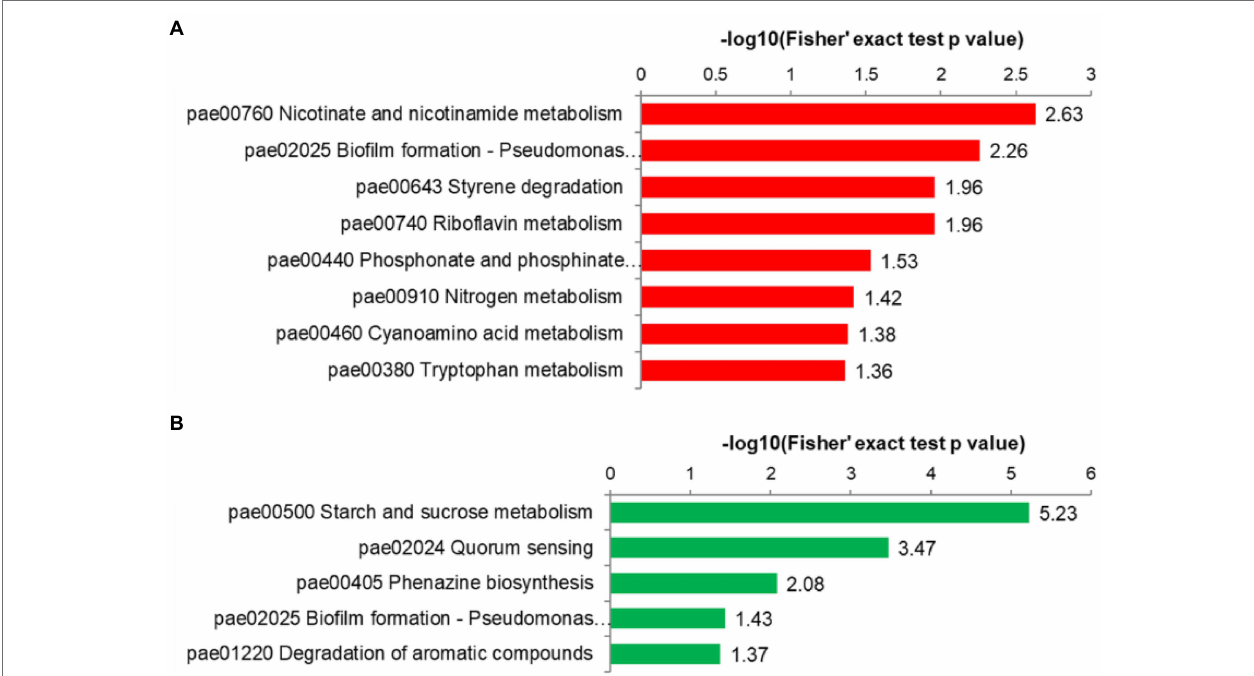
FIGURE 5 | Kyoto Encyclopedia of Genes and Genomes (KEGG) pathway enrichment analysis. (A) KEGG pathway enrichment results for upregulated proteins. (B) KEGG pathway enrichment results for downregulated proteins. The y axis denotes the categories of KEGG pathways. The x axis is the − log 10 for Fisher’s exact test of value of p for the significance of